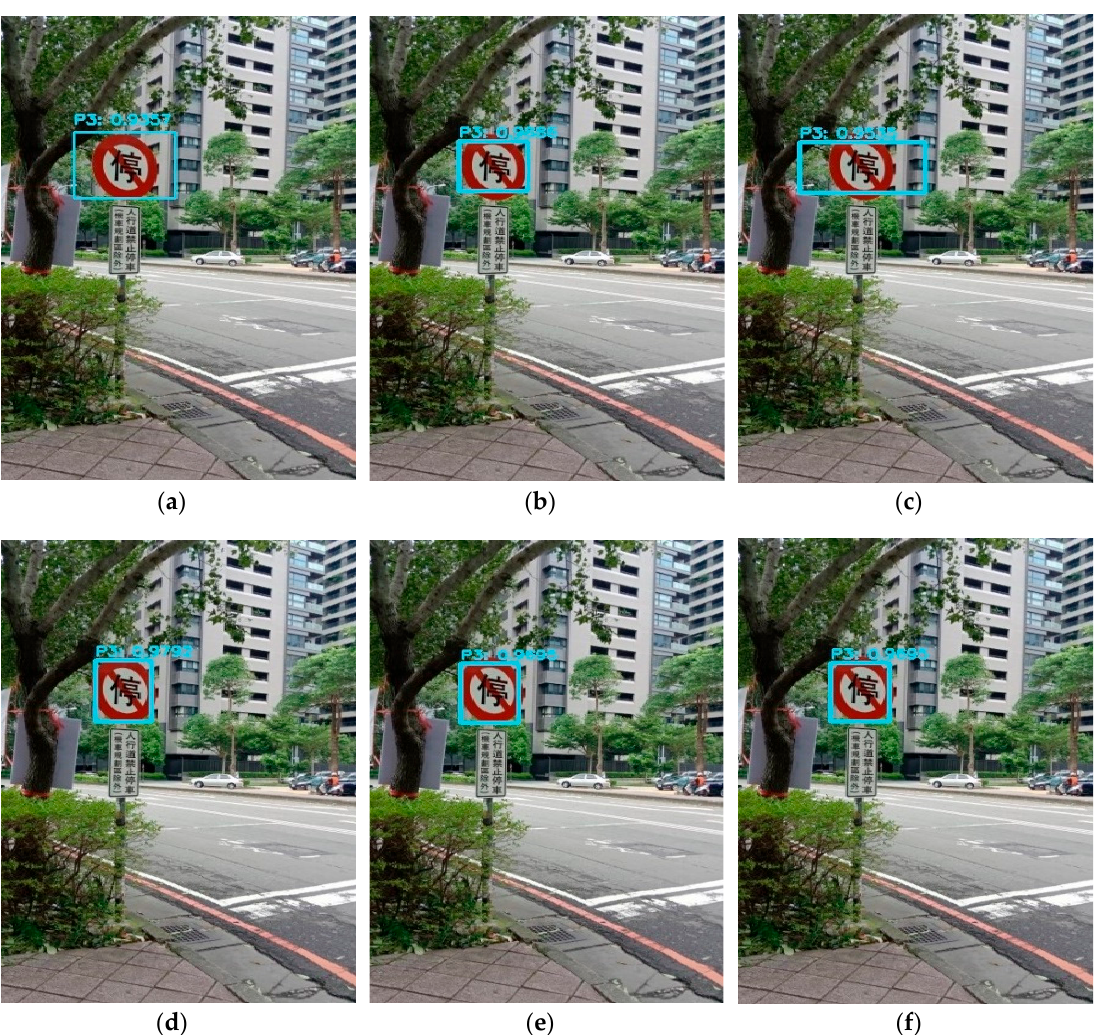
Figure 5. Recognition test for prohibitory sign class P3 by ( a ) Yolo V3 1, ( b ) Yolo V3 2, ( c ) Yolo V3 3, ( d ) Yolo V3 SPP 1, ( e ) Yolo V3 SPP 2, and ( f ) Yolo V3 SPP 3.